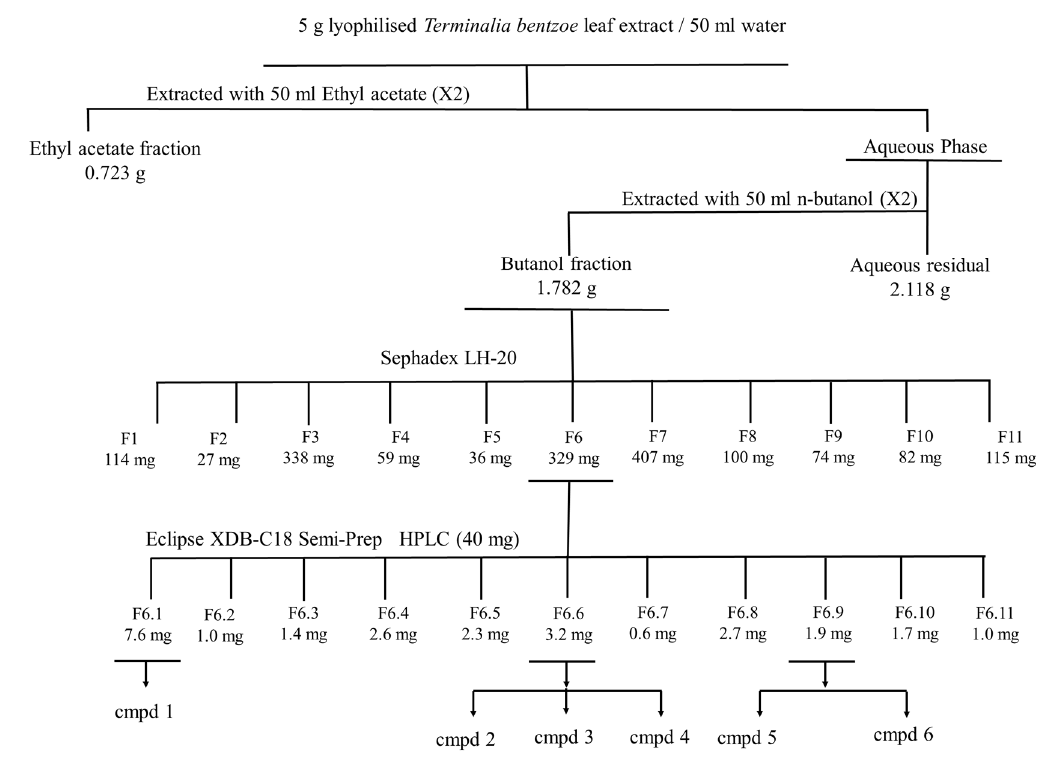
Figure 3. MTT-guided fractionation of T. bentzoë extract cytotoxicity against HepG2 cells. Cmpd: Compound. Figure 3. MTT ‐ guided fractionation of T. bentzoë extract cytotoxicity against HepG2 cells . Cmpd: Cmpd 1 = α and β - Punicalagin; compd 2 = Isoterchebulin; compd 3 = Terflavin A; cmpd 4 = Compound. Cmpd 1= α and β ‐ Punicalagin; compd 2 = Isoterchebulin; compd 3 = Terflavin A; cmpd 3,4,6-trigalloyl- β -D-glucopyranose; cmpd 5 = 2”- O -galloyl-orientin; cmpd 6 = 2”- O 4 = 3,4,6 ‐ trigalloyl ‐ β ‐ D ‐ glucopyranose; cmpd 5 = 2” ‐ O ‐ galloyl ‐ orientin; cmpd 6 = 2” ‐ O ‐ galloyl ‐ isoorientin.